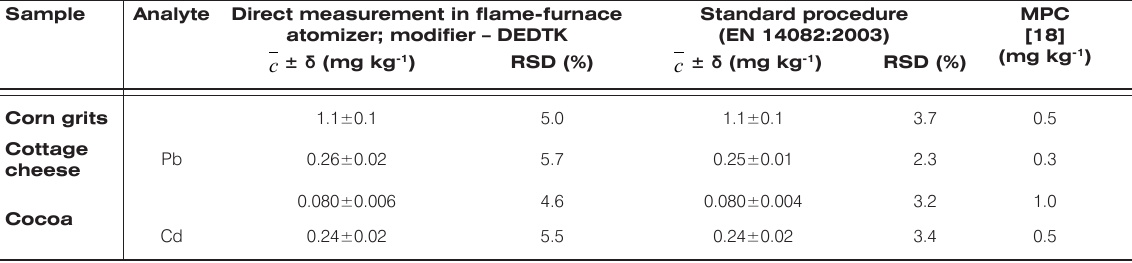
Table 2. Weight fraction of Pb and Cd in food (n=4; P=0.95).